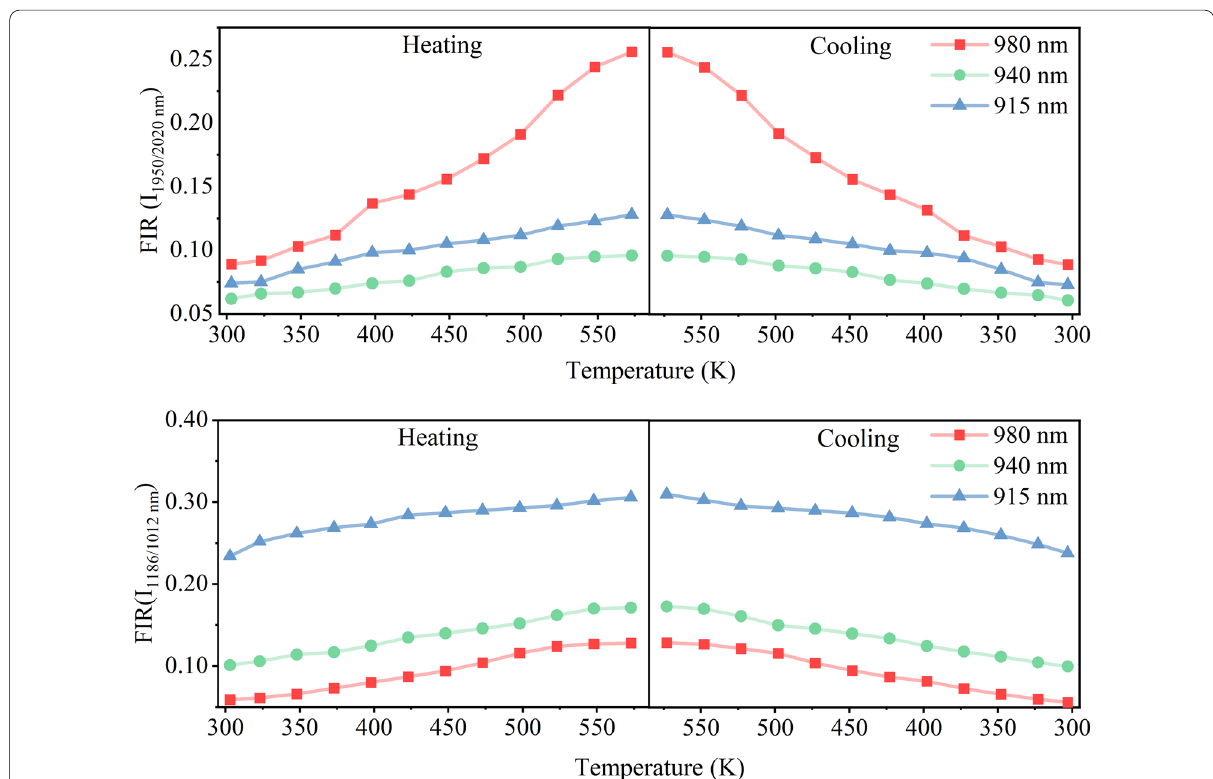
Fig. 9 The repeatability of FIR ( I 1186 / I 1012 and I 1950 / I 2020 ) in SrF 2 :Yb 3 + /Ho 3 + (12/0.1 mol%) NCs over an arbitrary heating and cooling circle under 980, 940 and 915 nm